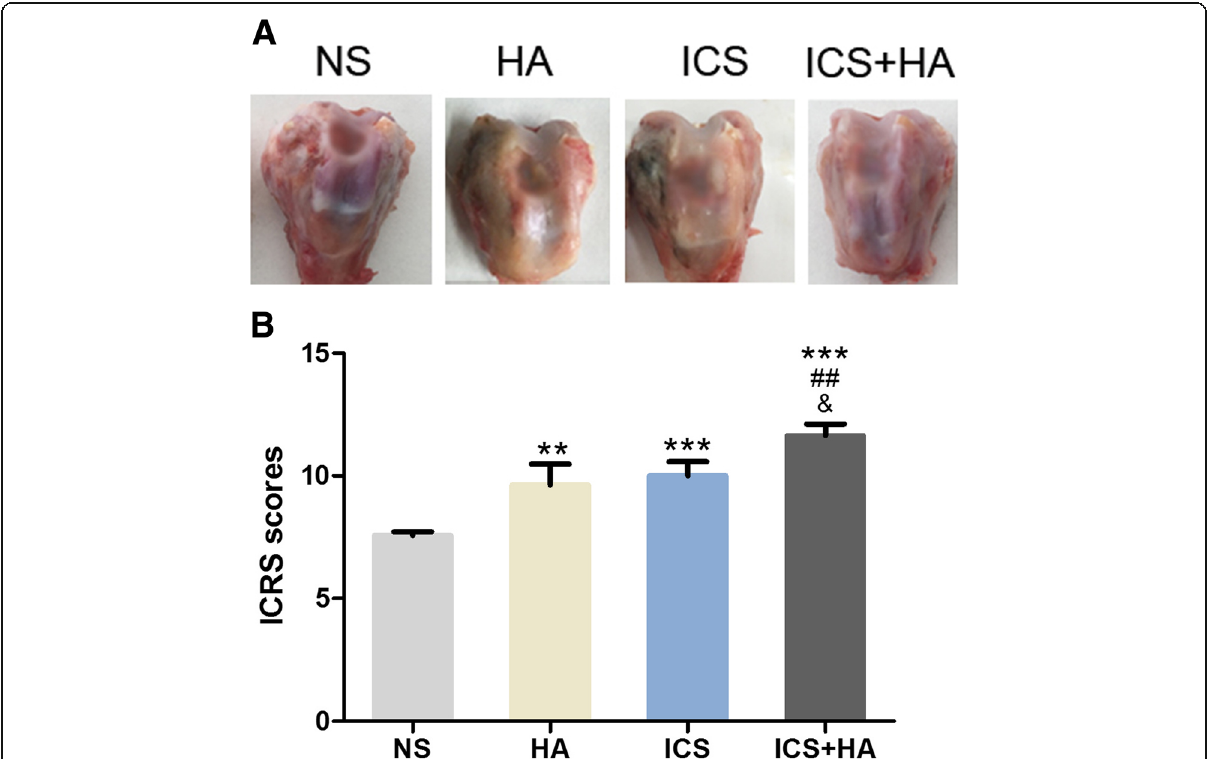
Fig. 3 Gross observation and evaluation of the repair of osteochondral defects in rabbit knees. a Gross observation of the repair of osteochondral defect. b Repair of osteochondral defects assessed by ICRS scores. ( n = 6, mean ± SD). Abbreviations: ICRS, international cartilage repair society; SD, standard